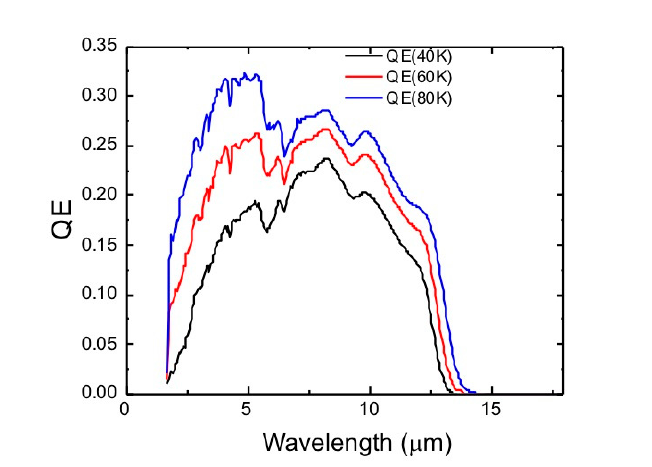
Figure 1. Backside illuminated spectral quantum efficiency (QE) for an LWIR detector measured at temperatures ranging from 40 K to 80